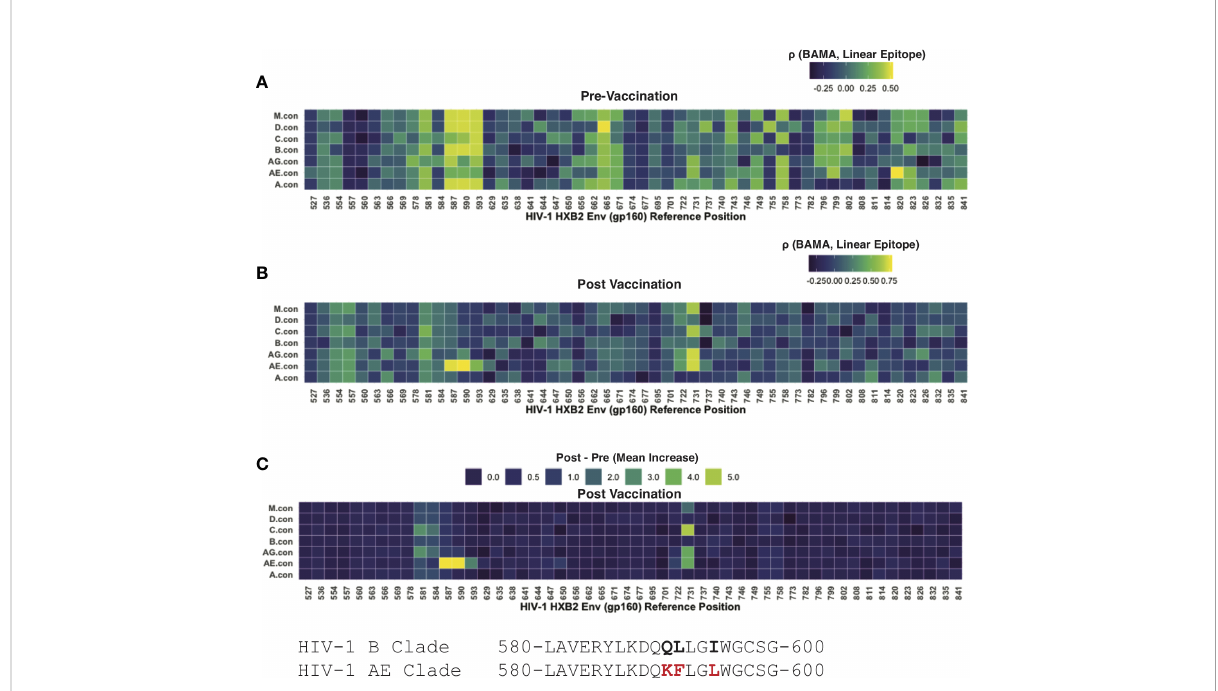
FIGURE 4 Linear epitope speci fi c anti-gp41 Ig responses measured by linear epitope microarray from participants in HVTN 106. (A) Rank correlation between BAMA measured anti-gp41 IgG and linear epitope binding signal prior-to-vaccination. (B) Rank correlation between BAMA measured anti-gp41 IgG and linear epitope binding signal after-to-vaccination. (C) Mean increase in linear-epitope response